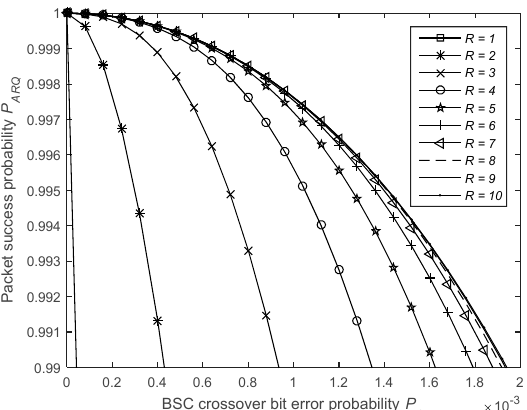
Figure 19. Impact of the number of 1-Rep-ACK transmission attempts on the packet success probability.